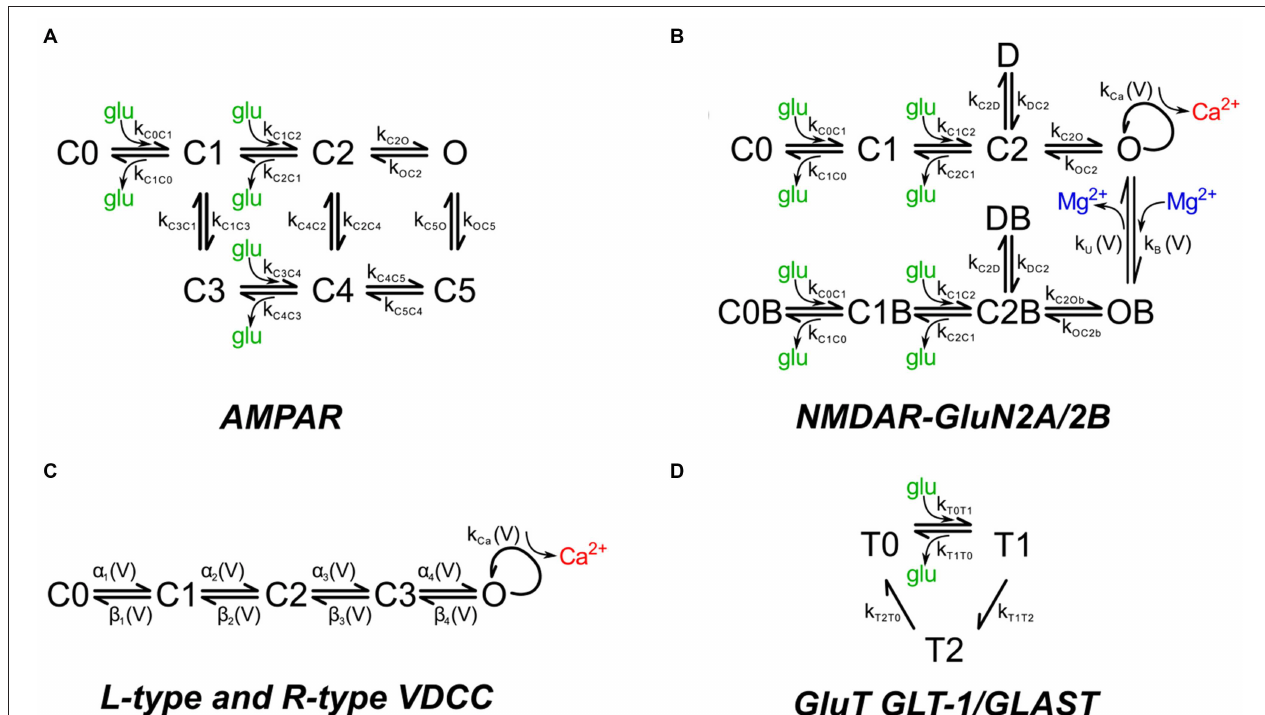
FIGURE 2 | Chemical kinetic schemes of receptors, Ca 2 + channels, and glutamate transporter. The kinetic rate constants for the reaction pathways are given in Table 1 . (A) Glutamate-gated AMPAR with a mixture of GluA1 and GluA2 subunits and (B) glutamate-gated NMDA receptor with a mixture of GluN2A (NR2A) and GluN2B (NR2B) subunits were distributed on the dendritic spine head plasma membrane associated with the PSD. Mg 2 + block was modeled by the asymmetric trapping block model of Vargas-Caballero and Robinson (2004). (C) Voltage-dependent Ca 2 + channels on the spine head and neck are the sole source of calcium during backpropagating action potentials. (D) Glutamate transporter representing a combination of GLT-1 and GLAST transporter subtypes were distributed on the astrocytic glial